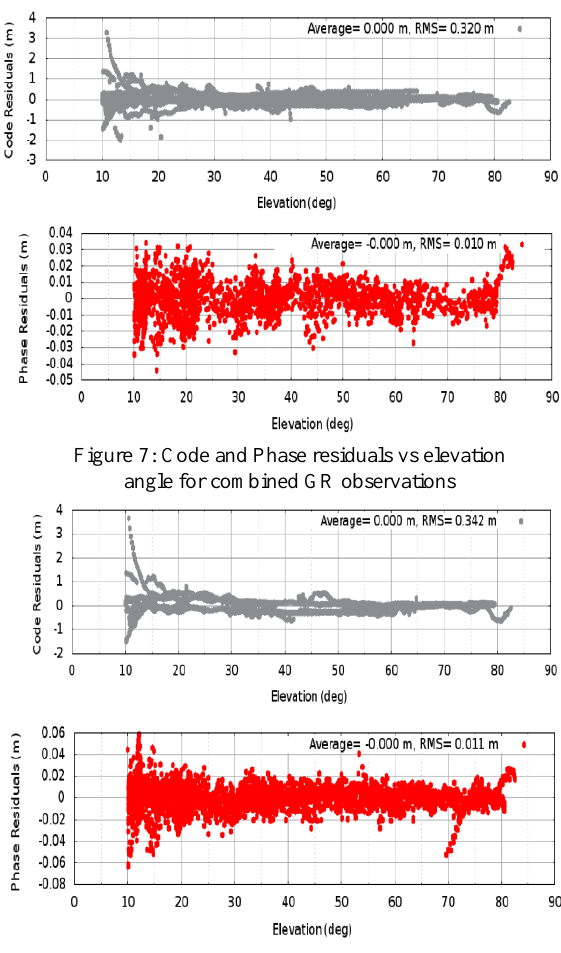
Figure 8: Code and Phase residuals vs elevation angle for G only observations